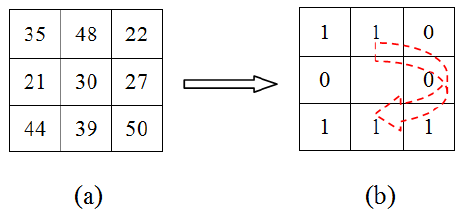
Figure 1. An example of LBP binary thresholding: ( a ) a 3 × 3 window; and ( b ) binary labels of the surrounding eight neighbors (in the clockwise